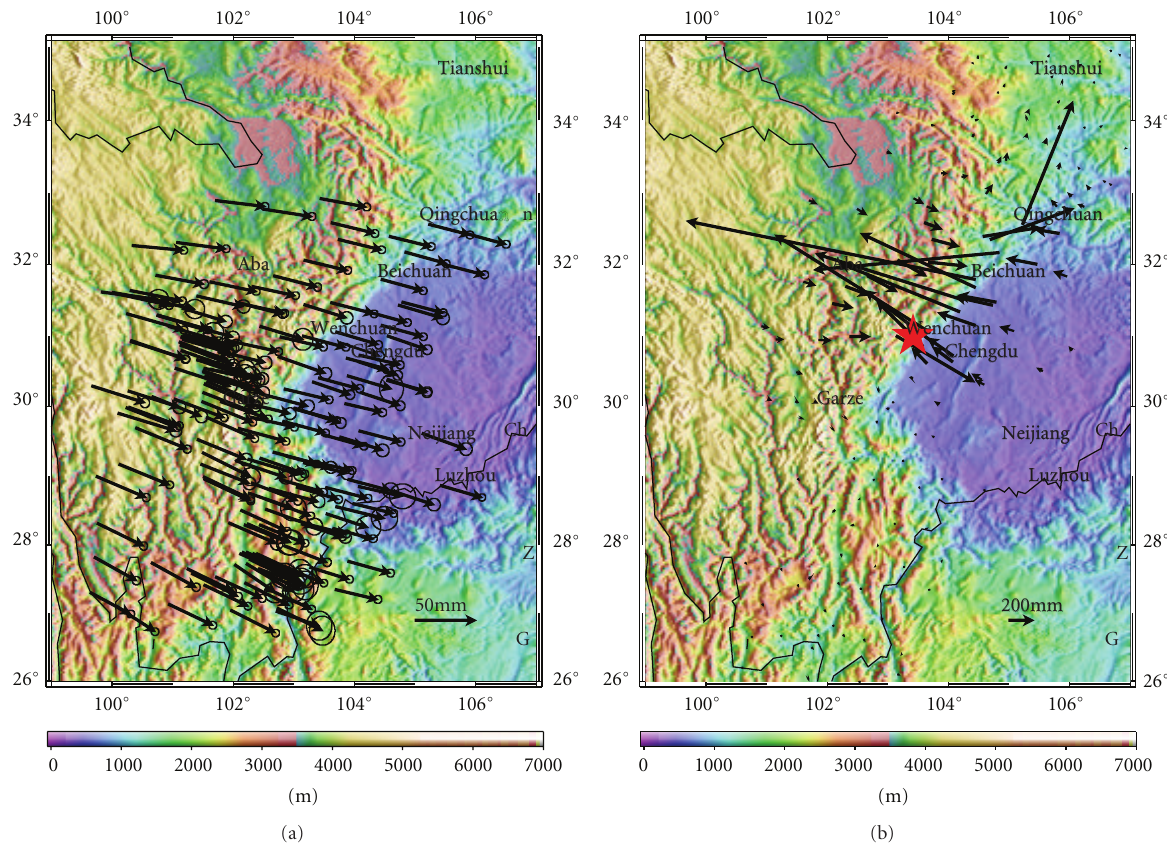
Figure 2: Movement observations of GPS stations. (a) The movement velocities of GPS stations before Wenchuan earthquake (In ITRF2005 with Eurasian plate fixed). (b) Horizontal coseismic displacements at GPS stations; red star is the locations of Wenchuan Ms8.0